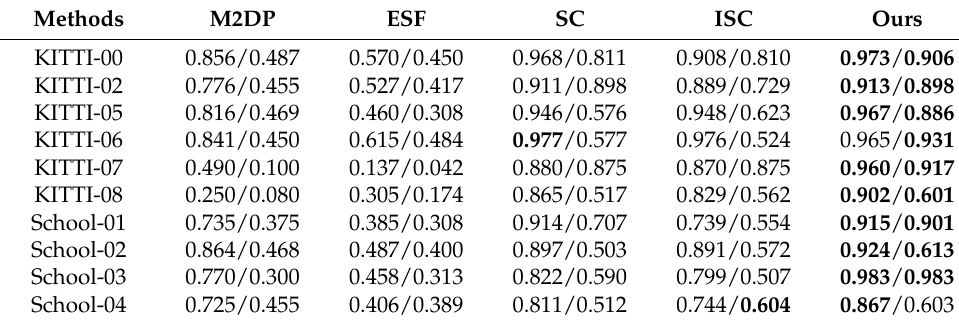
Table 6. F1 max scores and EP on KITTI and campus dataset.